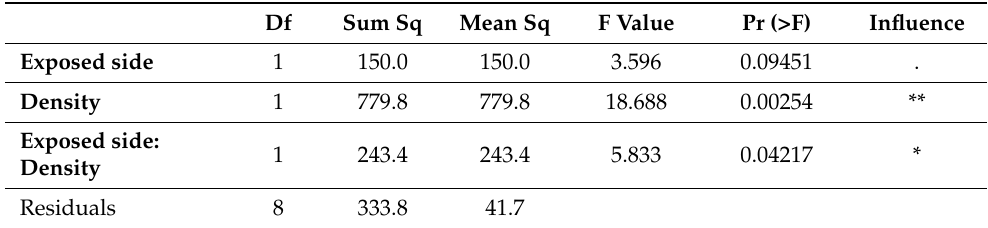
Table 2. Multivariate analysis of variance (ANOVA) of mass loss of thermowood specimens TP-R, TP-T, TF-R, TF-T at 780 s. Df Sum Sq Mean Sq F Value Pr (>F) Influence 1